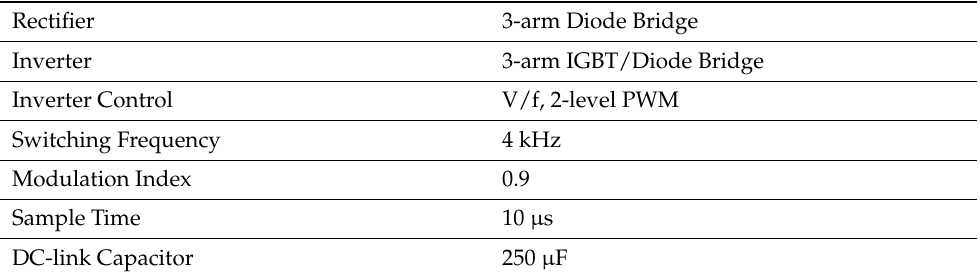
Table A3. VSD simulation parameters.